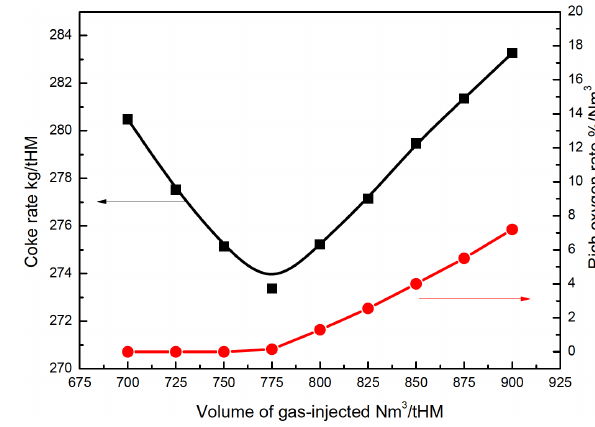
Figure 6: Effect of the injected gas volume on the coke rate in the gas-injection BF respondingly increase, which will result in a higher coke rate with more than 775 Nm 3 /tHM of injected gas. In